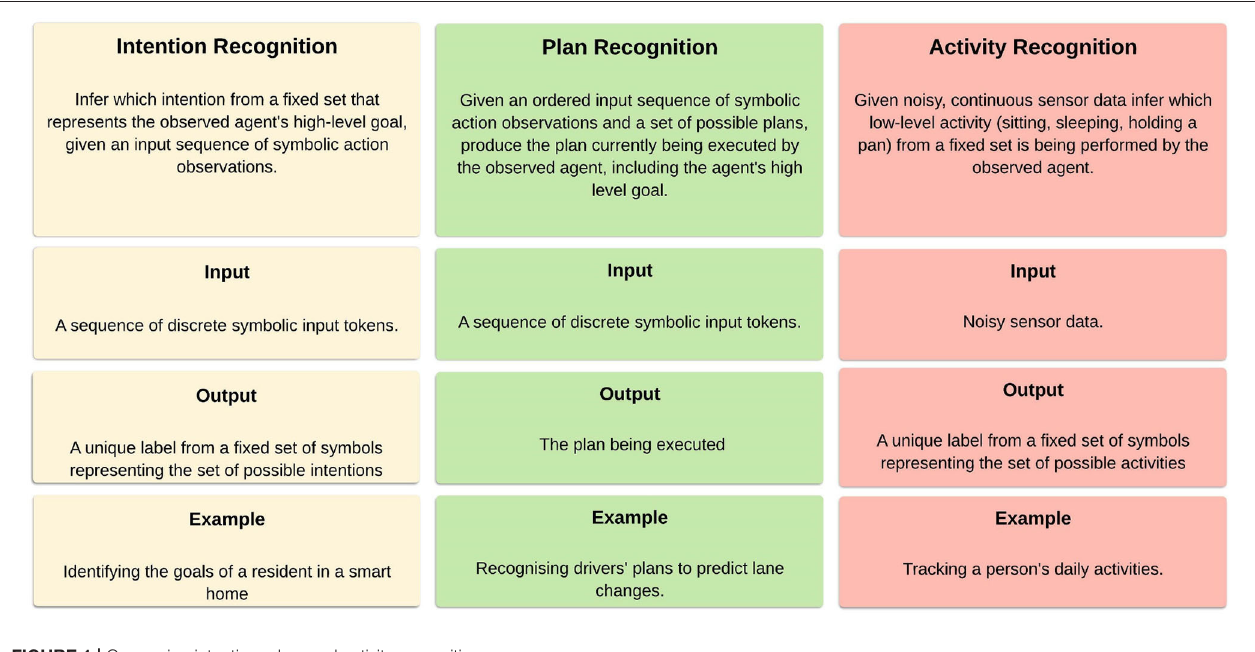
FIGURE 1 | Comparing intention, plan, and activity